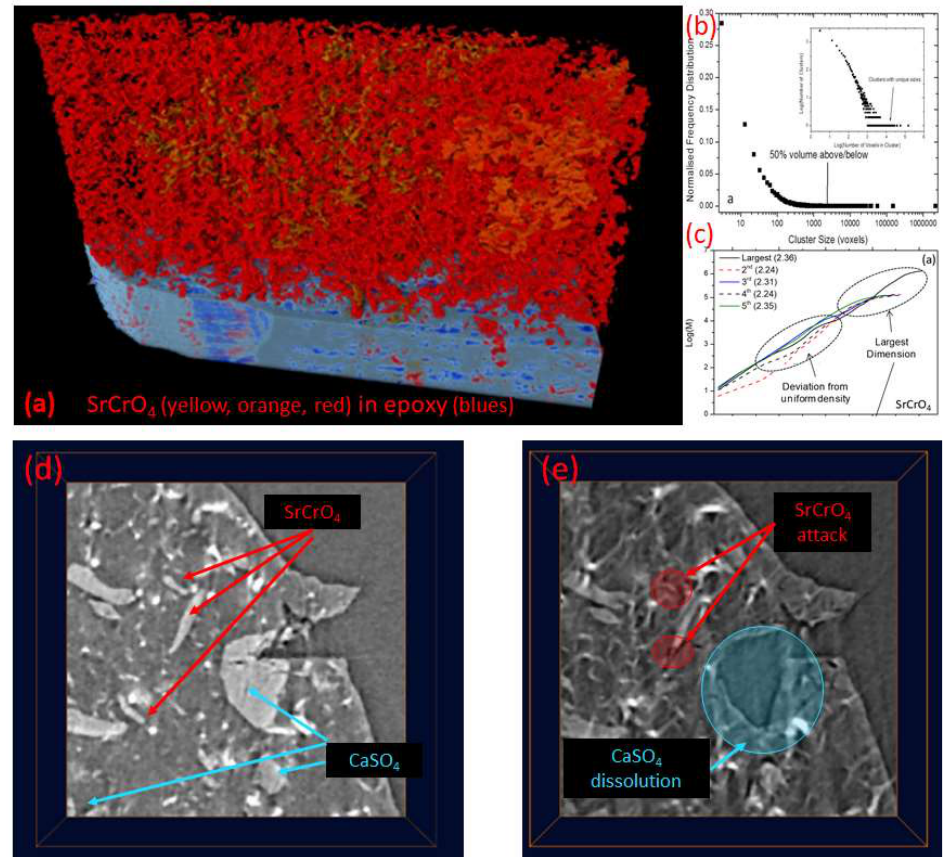
Figure 3. ( a ) Example of chromate clusters in yellow and orange among the rest of the SrCrO 4 particles in a piece with model coatings containing only SrCrO 4 particles and epoxy. ( b ) Cluster distribution size distribution and ( c ) cluster volume versus characteristic length, which yields the cluster fractal dimension. ( d ) Before and ( e ) after leaching CT slices of a defect in a model coating containing CaSO 4 and SrCrO 4 particles in an epoxy. Parts ( b ) and ( c ) were reproduced with permission from [60] .